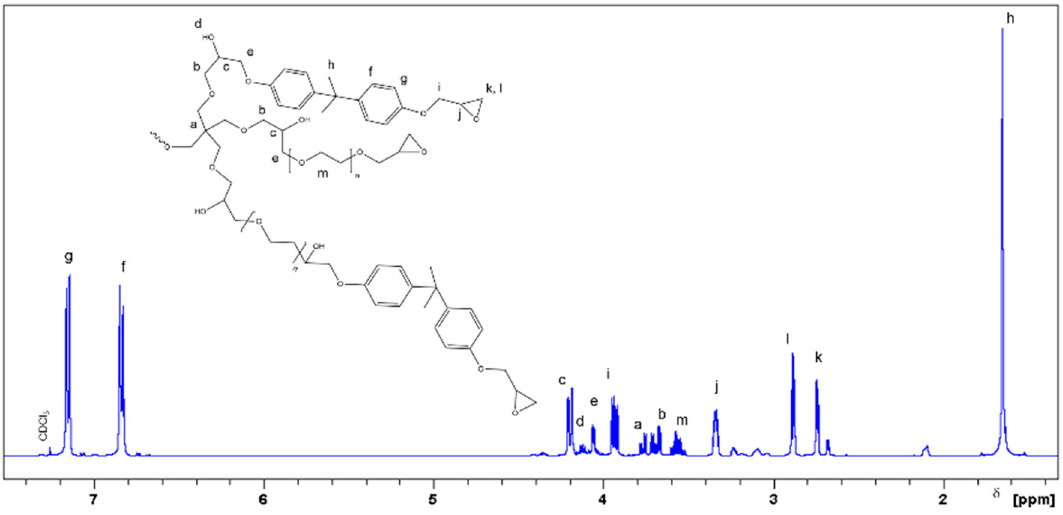
Figure 3. 1 H NMR spectrum of HBE5P resin.